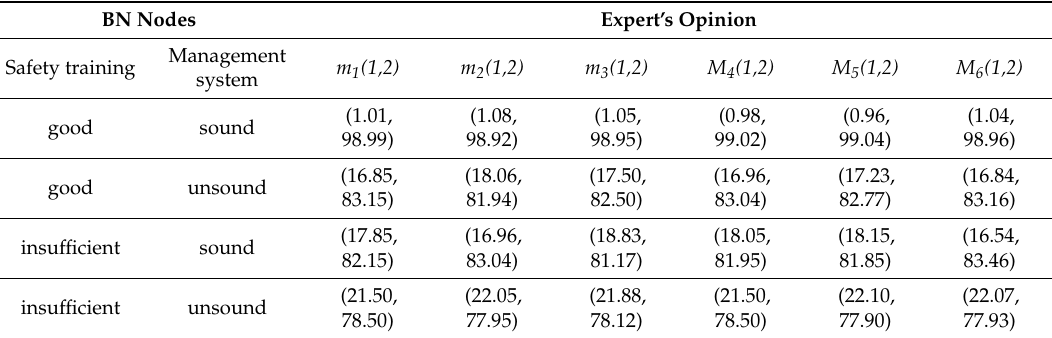
Table 2. Prior probability distribution of “Improper management” (%).